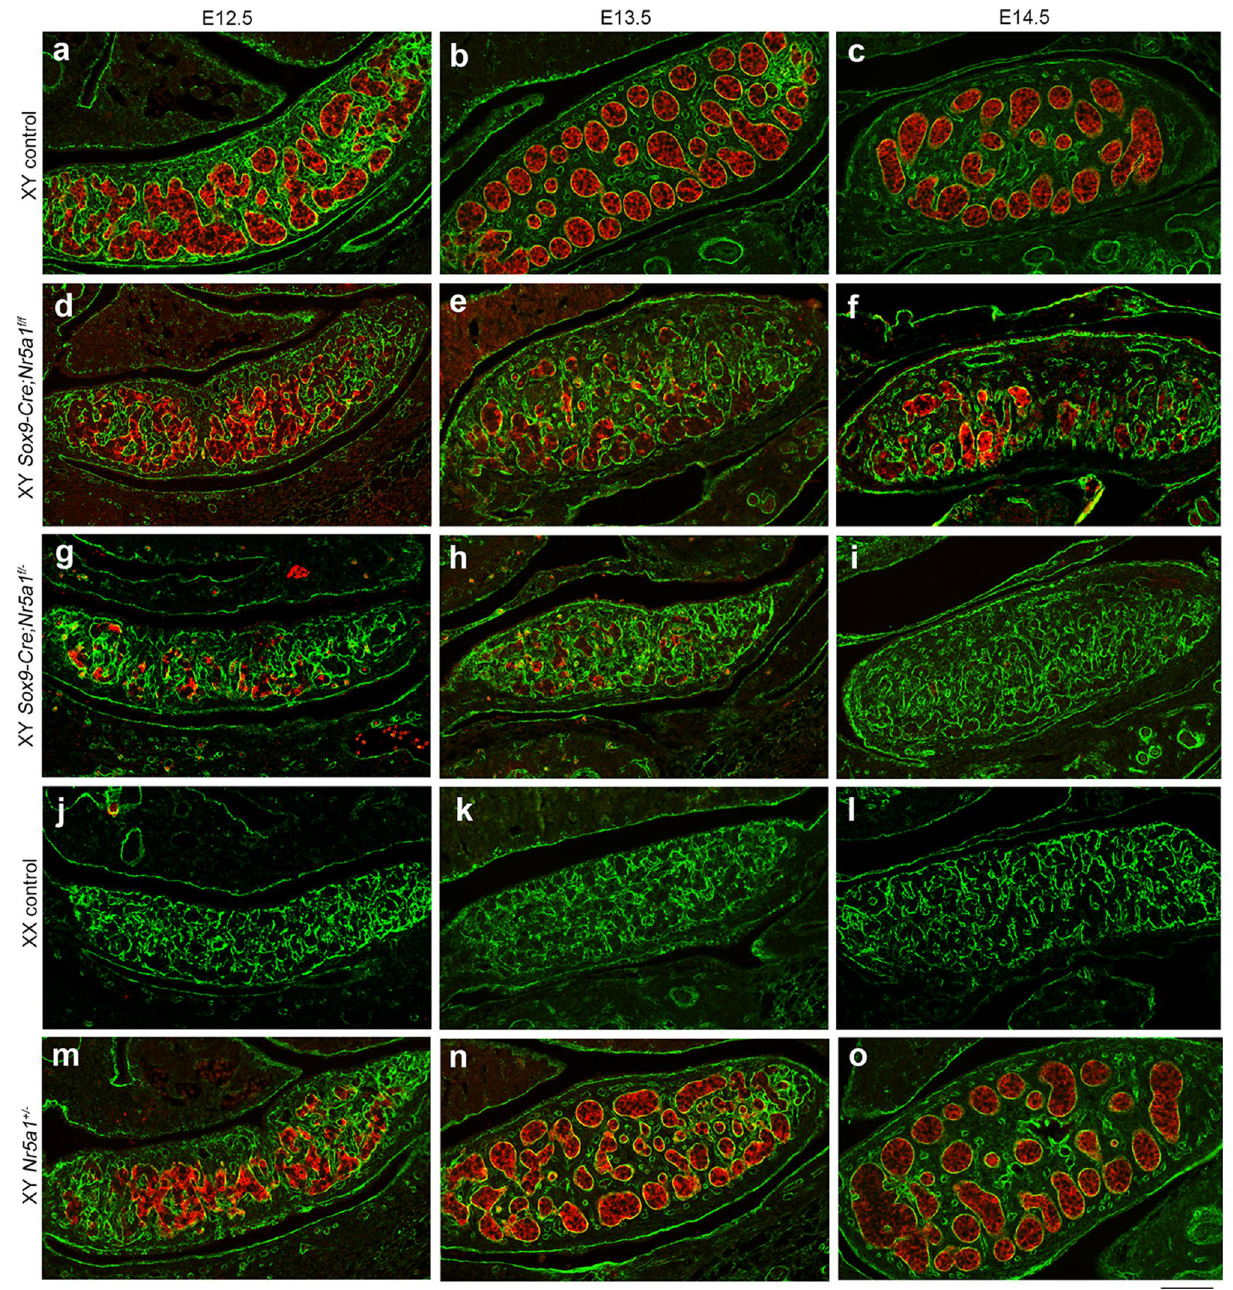
Figure 7. Disrupted testis cord formation in XY Sox9-Cre - Nr5a1 cKO gonads. Double IHC for laminin (green) and AMH (red) in gonads of XY control ( a – c ), XY Sox9-Cre;Nr5a1f. /f ( d – f ), XY Sox9-Cre;Nr5a1f. /− ( g – i ), XX control ( j – l ), and XY Nr5a1 + /− ( m – o ) mice at E12.5, E13.5, and E14.5 (left, middle, and right panels, respectively). Ventral, anterior, and posterior sides of gonad are upwards, right, and left, respectively. Scale bar, 100